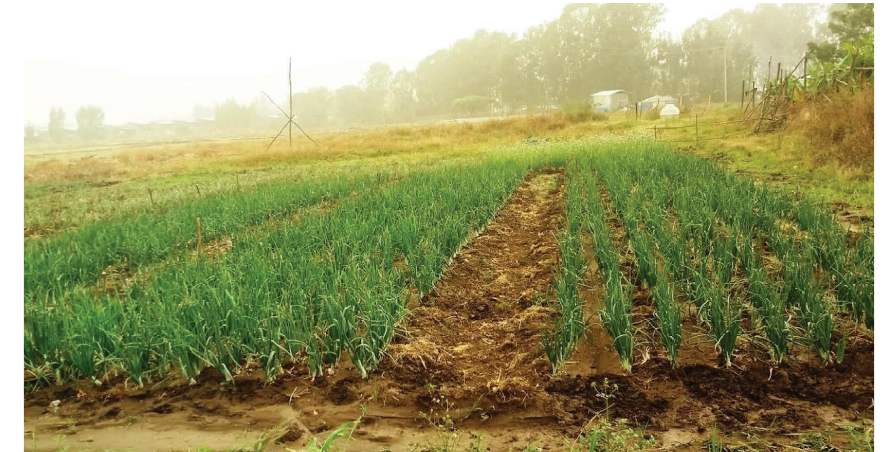
Figure 4: Vegetative growth of onion at the midgrowth